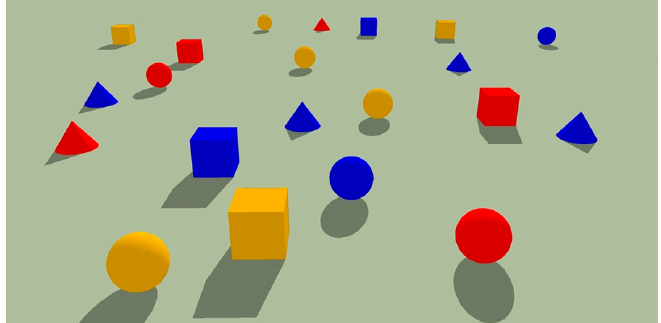
Figure 1. Stimulus used for G1–G2 in Exp. 1.1, intended to investigate shape guidance. The participants were asked to find all the spheres. The stimulus for Exp. 1.2 was similar.